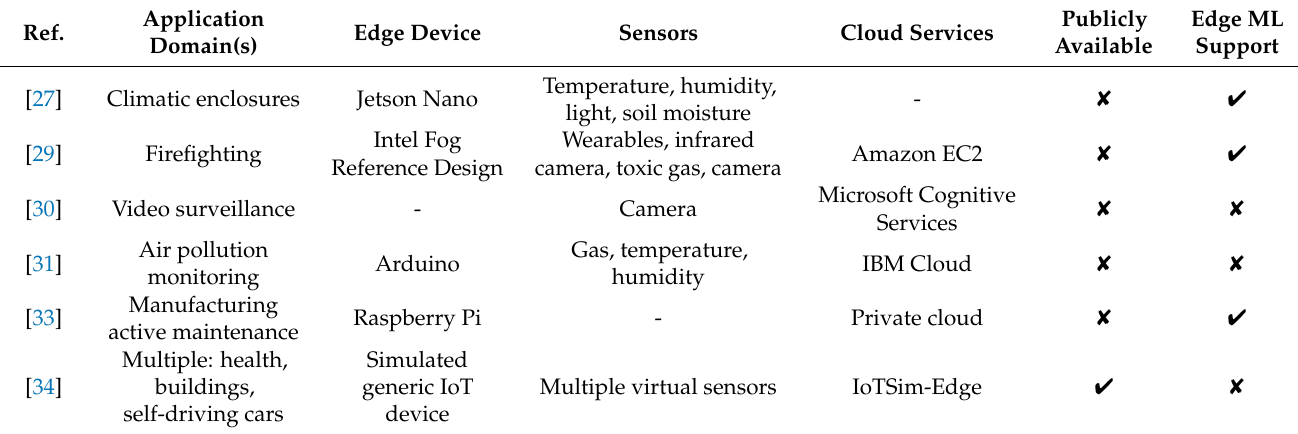
Table 1. Outlook of edge-computing